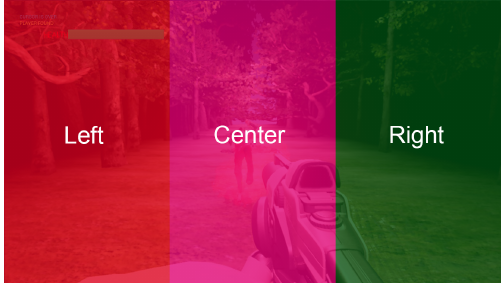
Figure 6. Tile/screen regions used to determine where to spawn an obstacle or